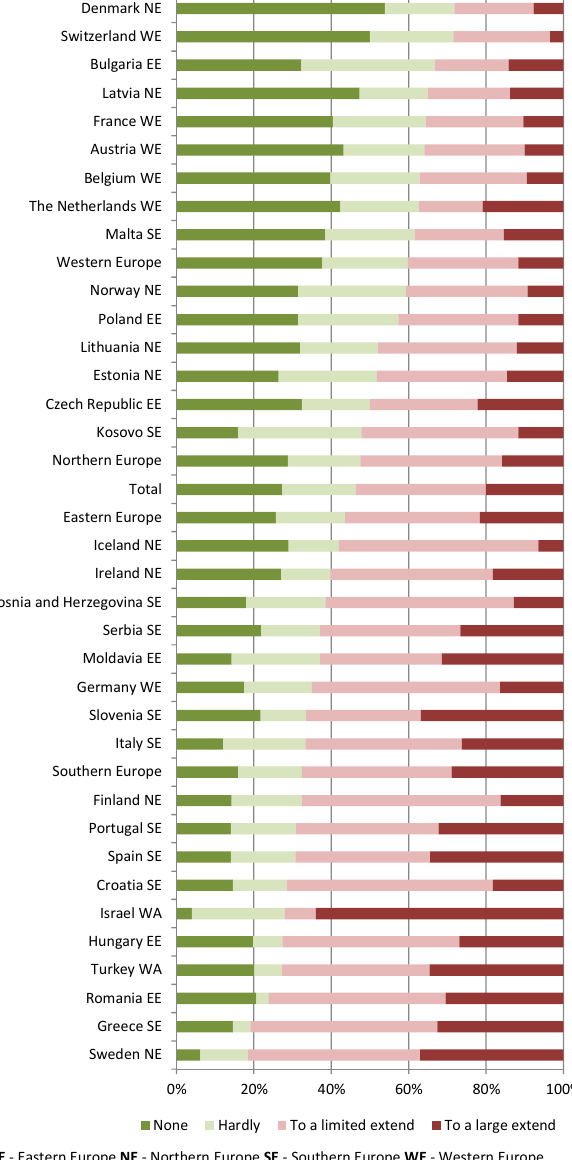
Figure 2. Considering making adjustments in the future to the building or the infrastructure.